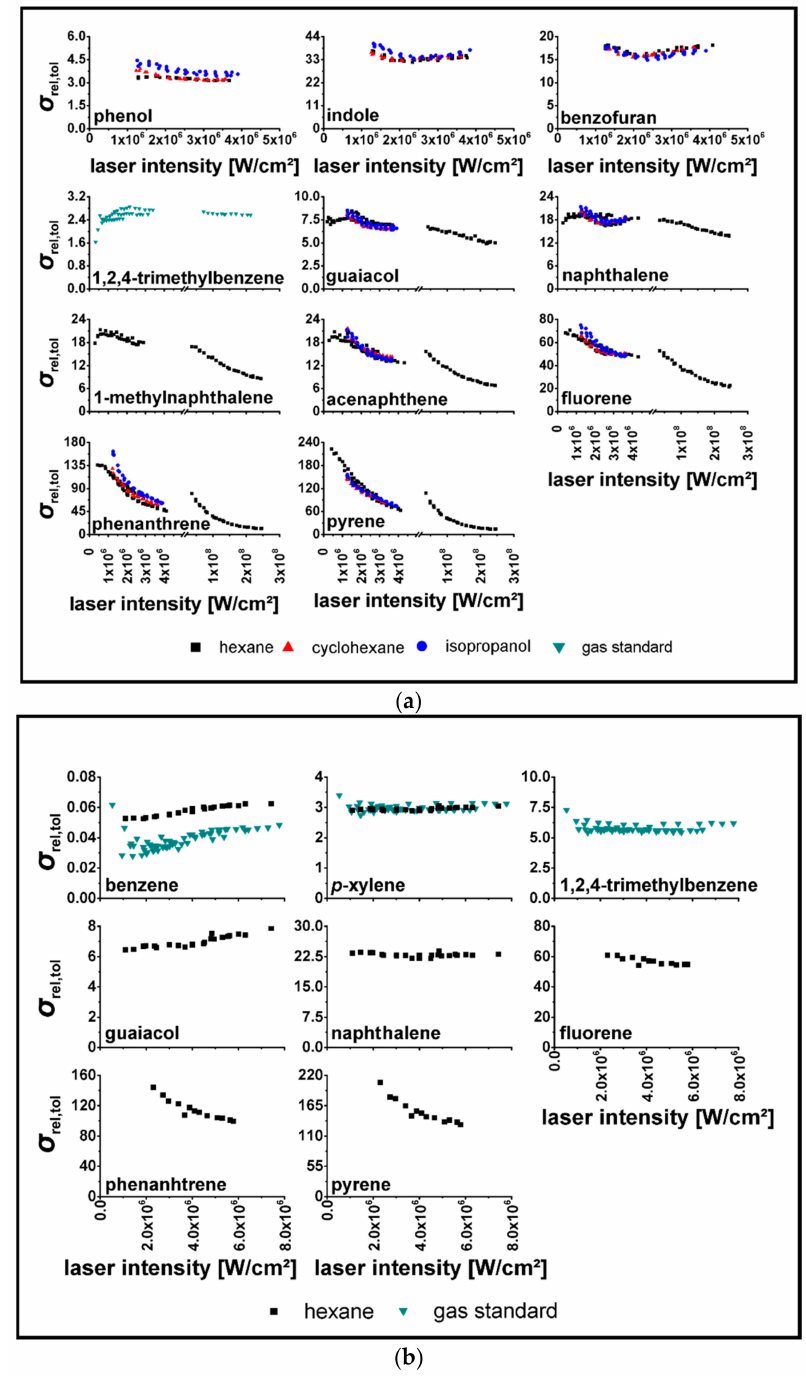
Figure 5. Relative REMPI cross sections ( σ rel,tol ; toluene was used as a reference substance) at 266 nm ( a ) obtained by PITOF 1; ( b ) obtained by PITOF 2. Clear intensity-dependent trends of σ rel,tol of PAHs were obtained, whereas for small aromatic compound constant values of σ rel,tol were determined. For 1,2,4-trimethylbenzene, only data of the gas standard were